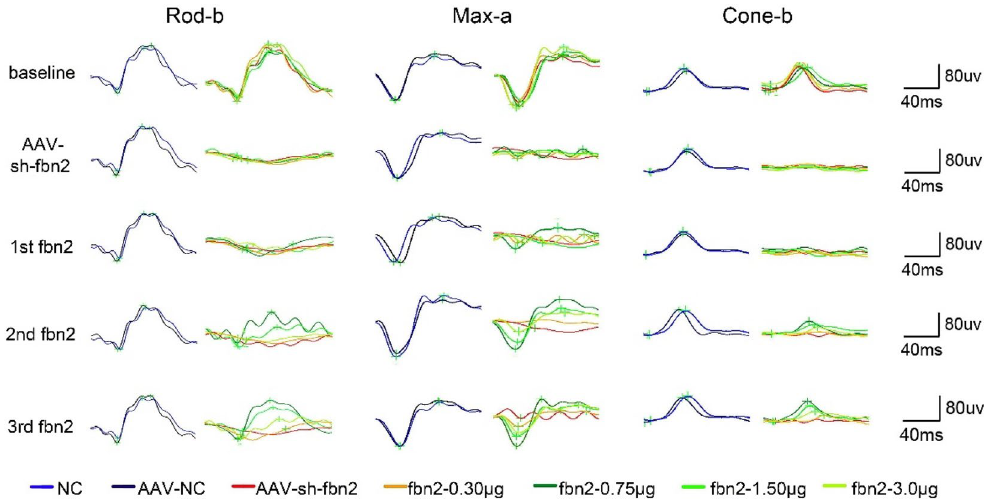
Figure 2. Electroretinographical analysis after intravitreal injection with empty carrier, AAV-sh-fbn2 or Fbn2 recombinant protein. NC group: Animals without intervention. AAV-NC group: Animals with an intravitreal injection of AAV empty vector and without any further treatment. AAV-sh-fbn2 group: Animals with an intravitreal injection of AAV-sh-fbn2 and without any further treatment. Fbn2-0.30 μg group: Animals with an intravitreal injection of AAV-sh-fbn2, followed by an intravitreal injection of fbn2 recombinant protein in a dose of 0.30 μg. Fbn2-0.75 μg group: Animals with an intravitreal injection of AAV-sh-fbn2, followed by an intravitreal injection of fbn2 recombinant protein in a dose of 0.75 μg. Fbn2-1.5 μg group: Animals with an intravitreal injection of AAV-sh-fbn2, followed by an intravitreal injection of fbn2 recombinant protein in a dose of 1.50 μg. Fbn2-3.0 μg group: Animals with an intravitreal injection of AAV-sh-fbn2, followed by an intravitreal injection of fbn2 recombinant protein in a dose of 3.00